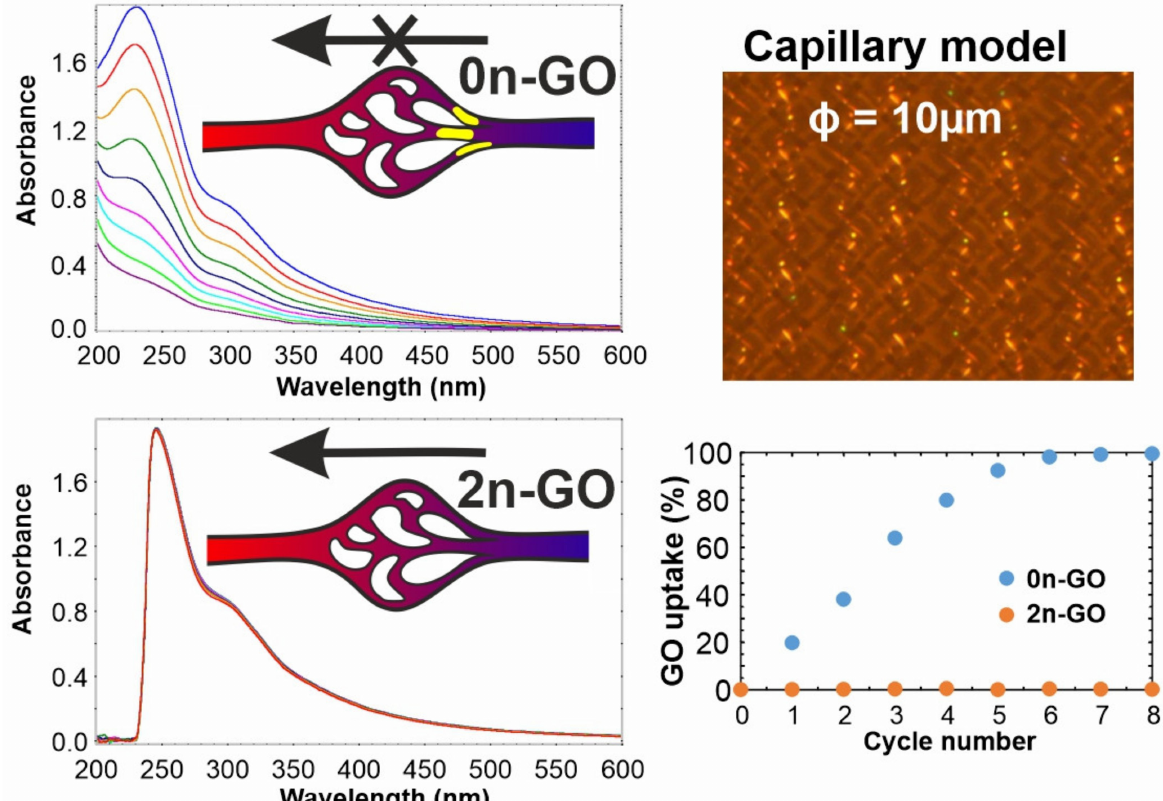
Figure 7. UV-Vis spectra of 2n-GO and 0n-GO down-flow. 0n-GO concentration decreases during the experiment, whereas the 2n-GO amount in solution after eight flow cycles was not